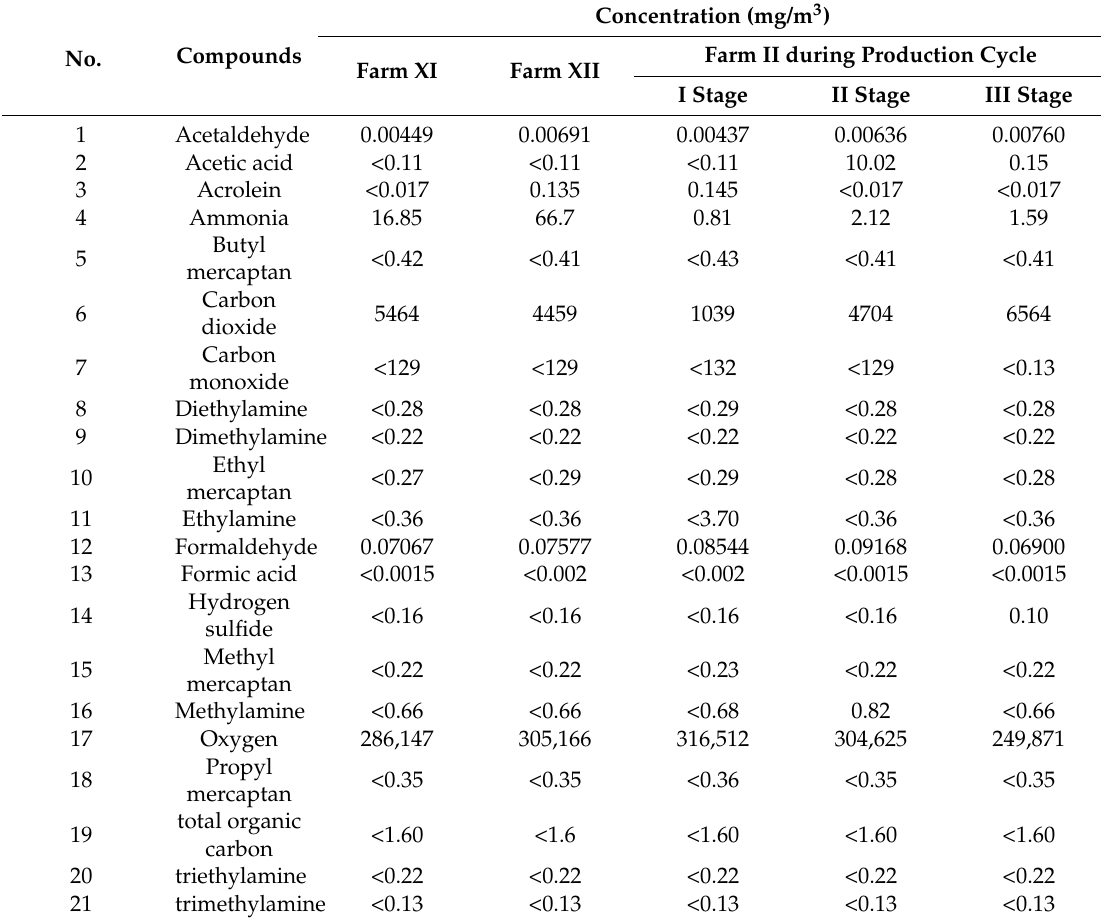
Table 9. Concentration of volatile odorous compounds in the